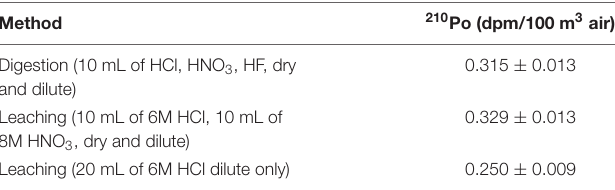
TABLE 2 | Activities for aerosol filter aliquots processed by total digestion or two leaching methods.